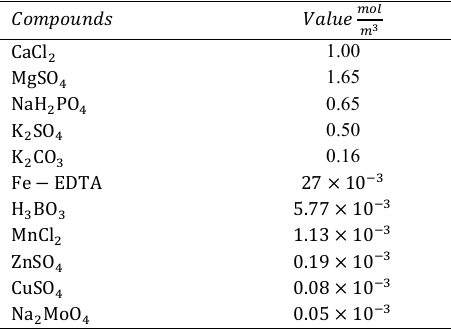
Table 1: Composition of the culture medium